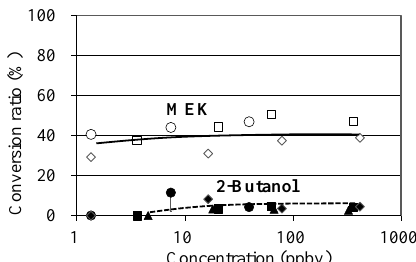
Figure 4. Concentration-dependency of MVK conversions to MEK and 2-butanol. Open and filled symbols indicate conversion ratios from MVK to MEK and to 2-butanol, respectively. Circle, square, and triangle symbols show the 1st, 2nd, and 3rd experiments, respectively. The GC-MS analysis was conducted in triplicate for the air collected into the adsorbent tubes, and standard deviations were all less than 30% of each plotted data point.